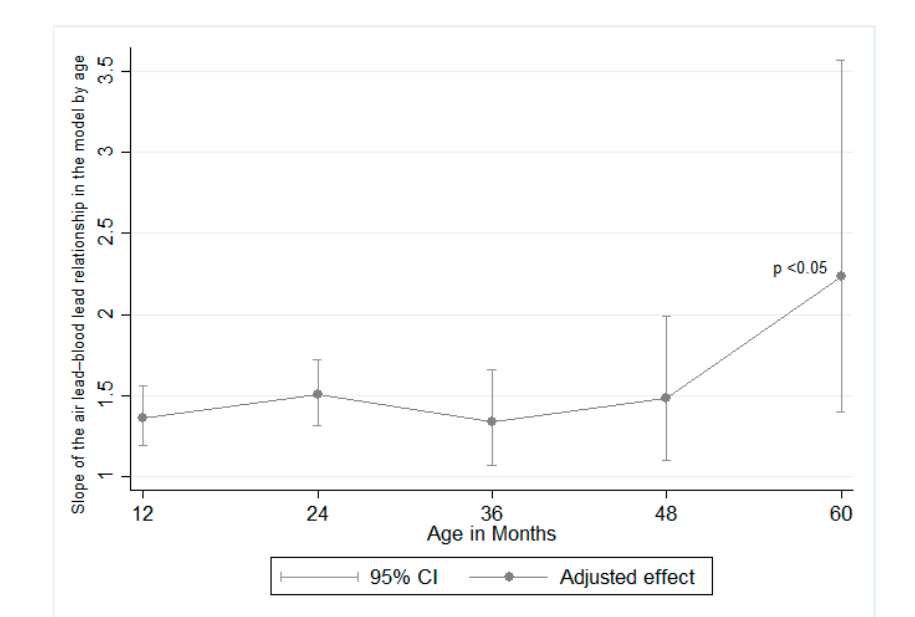
Figure 2. Contribution of lead in air on blood lead levels at each age. The 5-year slope of air lead on blood lead was significantly higher than the 1-year slope.